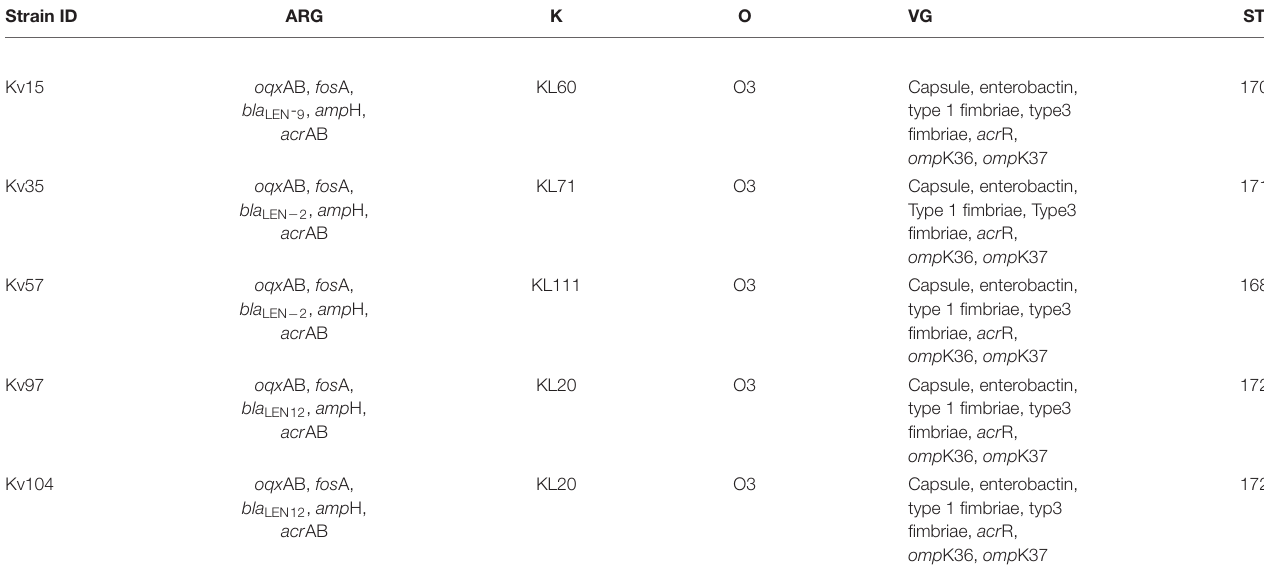
TABLE 2 | Antimicrobial resistance genes (ARG), virulence genes (VG), and molecular typing of Klebsiella variicola strains. Strain